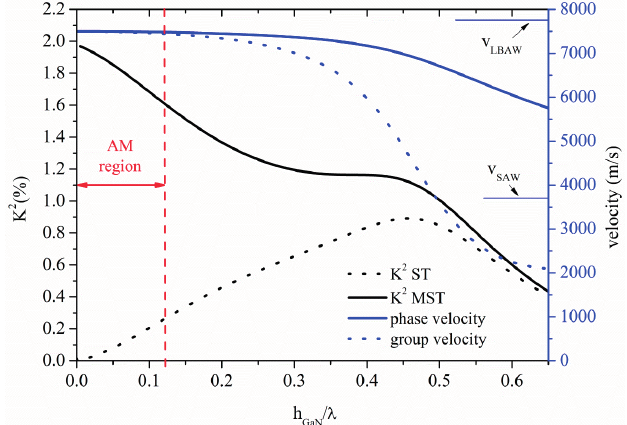
Figure 10. Phase velocity and K 2 dispersion curves of the S 0 mode propagating along the MST and ST configurations on GaN